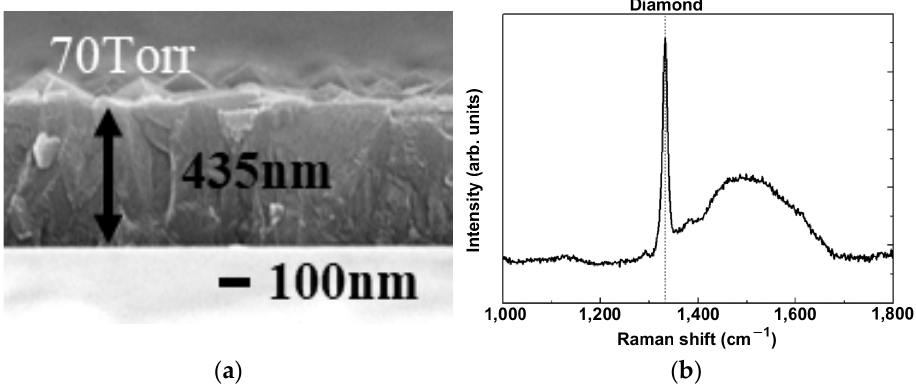
Figure 11. Measurement of ( a ) the film thickness and ( b ) Raman spectroscopy of the diamond film grown on the graphite substrate with working gas containing 0.25% methane.